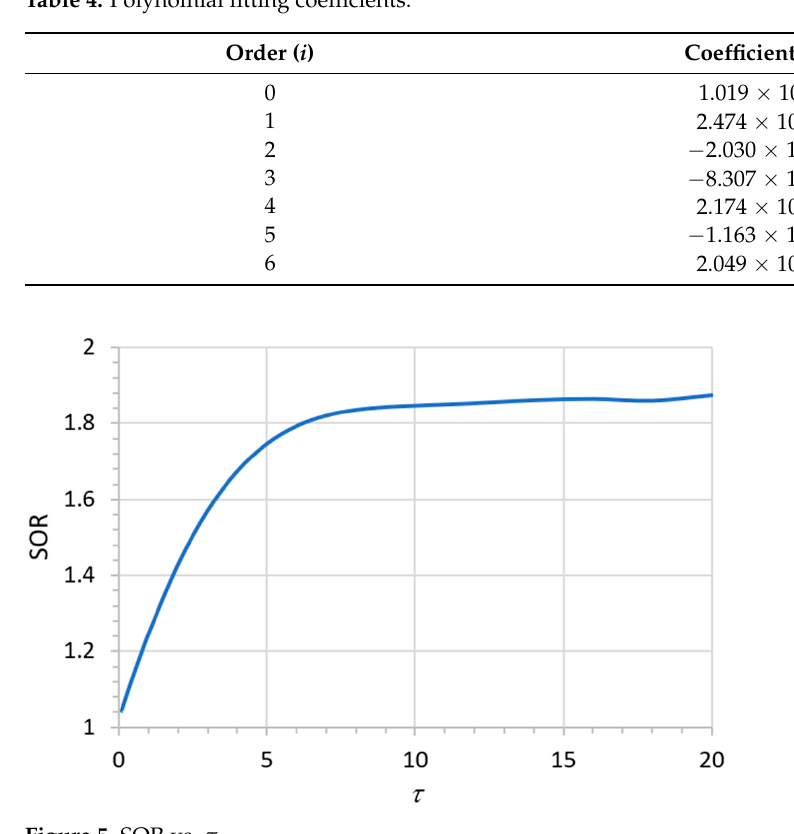
Figure 5. SOR vs. (cid:2028)